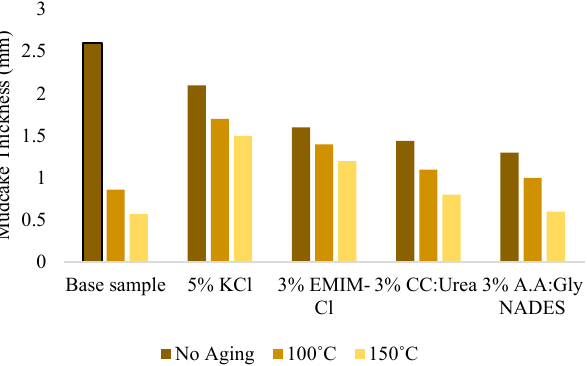
Figure 5. Mud cake thickness of AA:Gly NADES-based mud.